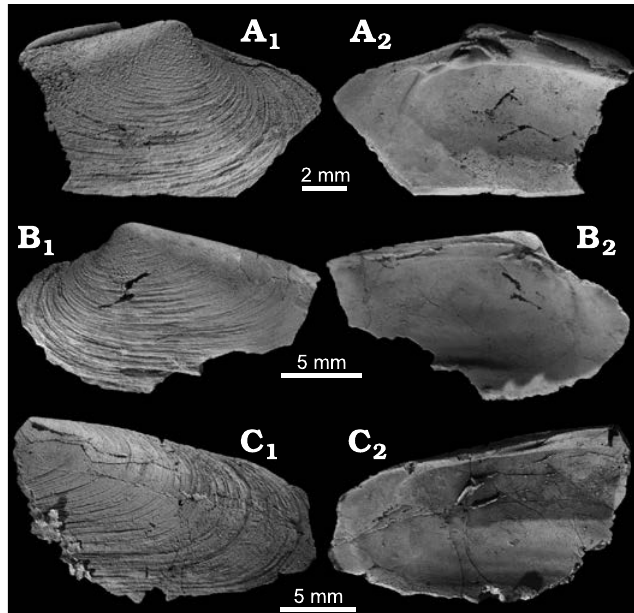
Fig. 3. The vesicomyid bivalve Squiresica knapptonensis (Amano and Kiel, 2007) from the upper Oligocene part of the Lincoln Creek Formation at Knappton, along the Columbia River, western Washington, USA. A . Holo- type USNM 534954, left valve showing external surface (A 1 ) and hinge (A 2 ). B . Paratype USNM 534956, left valve showing external surface (B 1 ) and hinge (B 2 ). C . USNM 534955, posterior part of a left valve showing external surface (C 1 ) and the posterior end of the nymphal ridge (C 2 ). All images (except C 2 ) from Amano and Kiel